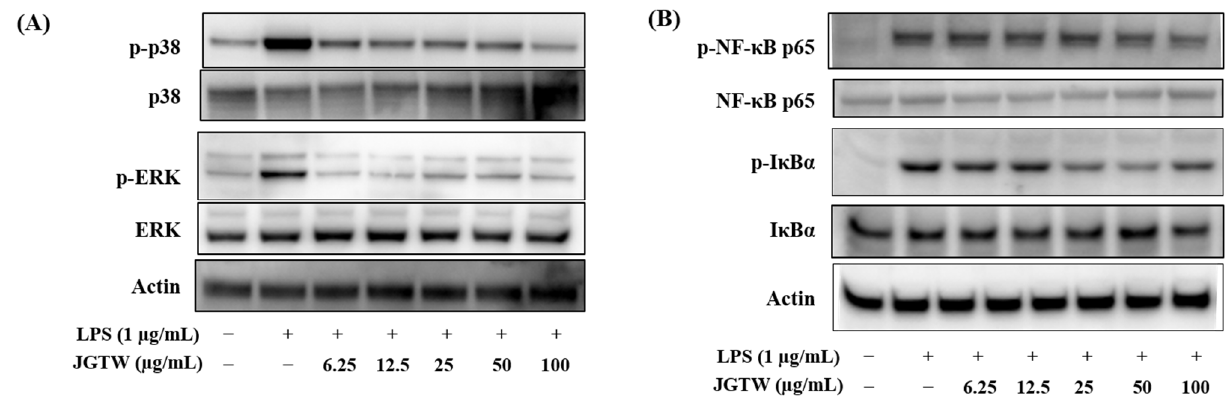
Figure 7. Effect of JGTW on LPS-stimulated activation of MAPK and NF- κ B signaling in RAW264.7 cells. Cells were pretreated with JGTW (6.25 to 100 μ g/mL) and then stimulated with LPS (1 μ g/mL) for 24 h. Total protein was isolated and the levels of p38 and ERK activation ( A ) and NF- κ B and I κ B activation ( B ) were determined by Western blot analysis.